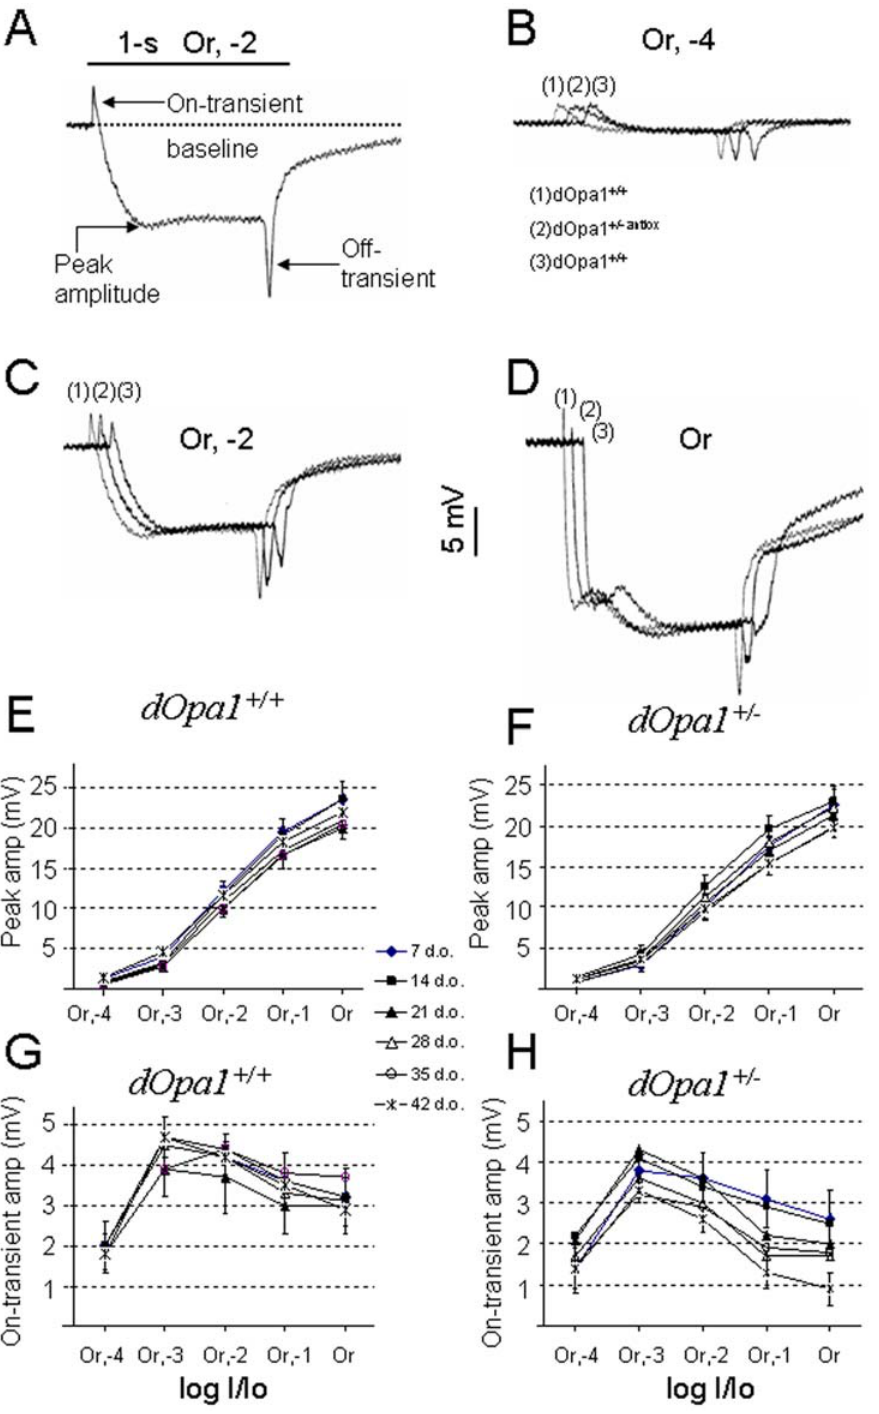
Figure 1. Electroretinogram analyses show an age-dependent reduction in the on-transient but not in the phototransduction response in heterozygous dOpa1(dOpa1 + / 2 ) mutants. (A) A typical ERG response showing on-/off-transients and peak amplitude when elicited with an Or, -2 stimulus. (B) Typical ERGs obtained from 42 d.o. dOpa1 + / + , dOpa1 + / 2 antiox and dOpa1 + / 2 using Or, -4 light stimuli are superimposed. The on-transients and peak amplitudes from the three Drosophila types are comparable. (C) Typical ERGs from 42 d.o. dOpa1 + / + , dOpa1 + / 2 antiox and dOpa1 + / 2 during light stimulus with Or, -2 were superimposed. The on-transient, but not the peak amplitudes, from dOpa1 + / 2 were smaller than those of dOpa1 + / + and dOpa1 + / 2 antiox . (D) Typical ERGs from 42 d.o. dOpa1 + / + , dOpa1 + / 2 antiox and dOpa1 + / 2 during light stimulus with Or were superimposed. The on-transients of dOpa1 + / 2 and dOpa1 + / 2 antiox , but not the peak amplitudes, were significantly smaller than those of dOpa1 + / + . (E) V-log I curves and (G) on-transient amplitudes vs log I from 7, 14, 21, 28, 35 and 42 d.o. dOpa1 + / + show no age-dependent reduction in on-transient and peak amplitude responses of the photoreceptor component. V-log I curves from 7, 14, 21,28, 35, and 42 d.o. dOpa1 + / 2 show no age-dependent reduction in peak amplitude responses (F) while the on-transient amplitudes vs log I curves from dOpa1 + / 2 show an age-dependent reduction in on- transient amplitudes (H).